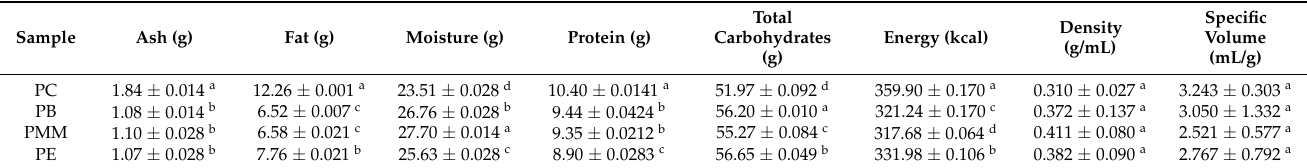
Table 1. Proximal chemical composition of 100 g of